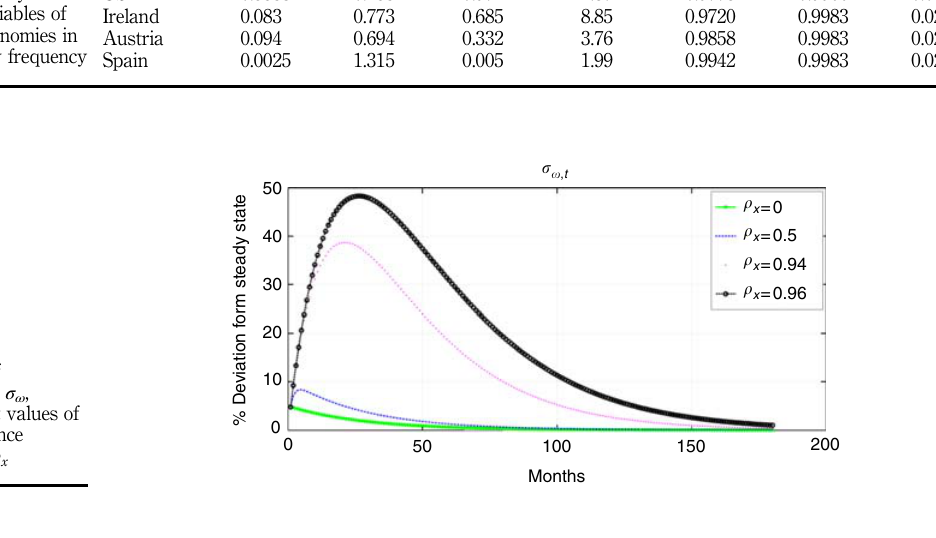
Table V. Calibration key credit channel variables of the four economies in